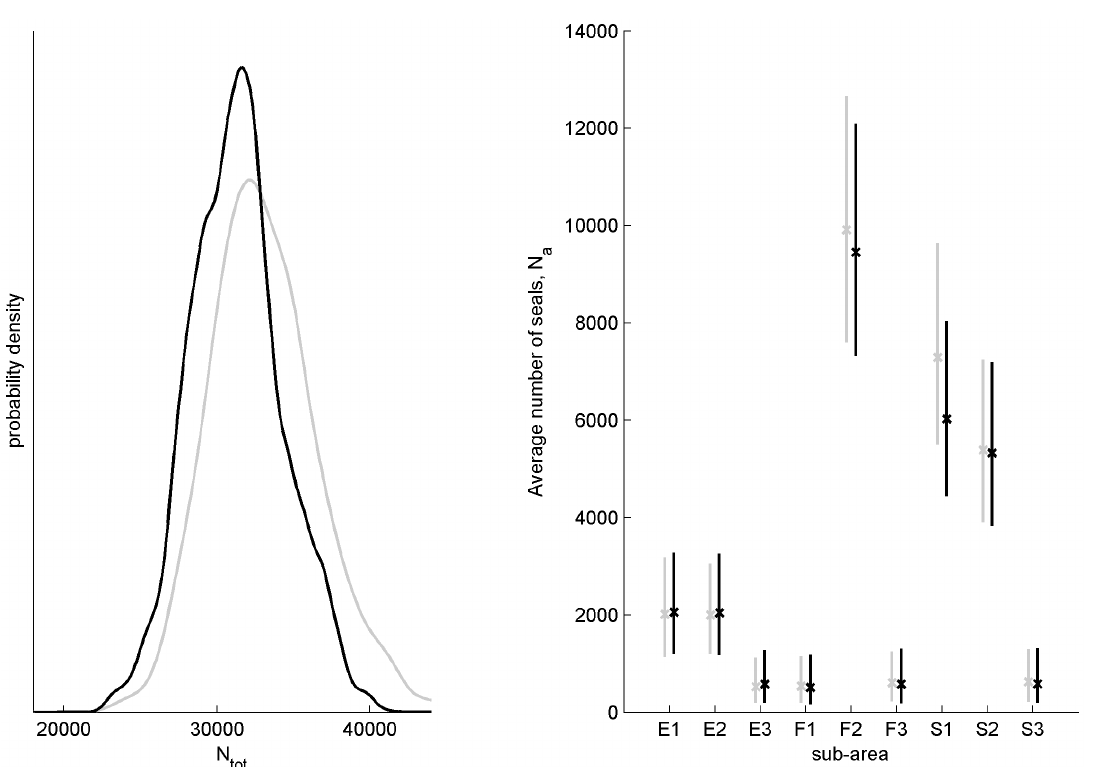
Figure 4. On the left, the posterior (black) and prior (grey) distribution of the number of seals that have survived other mortality sources than by- catch. On the right, the posterior (black) and prior (grey) median (cross) and central 90% credible interval of the average number of seals in